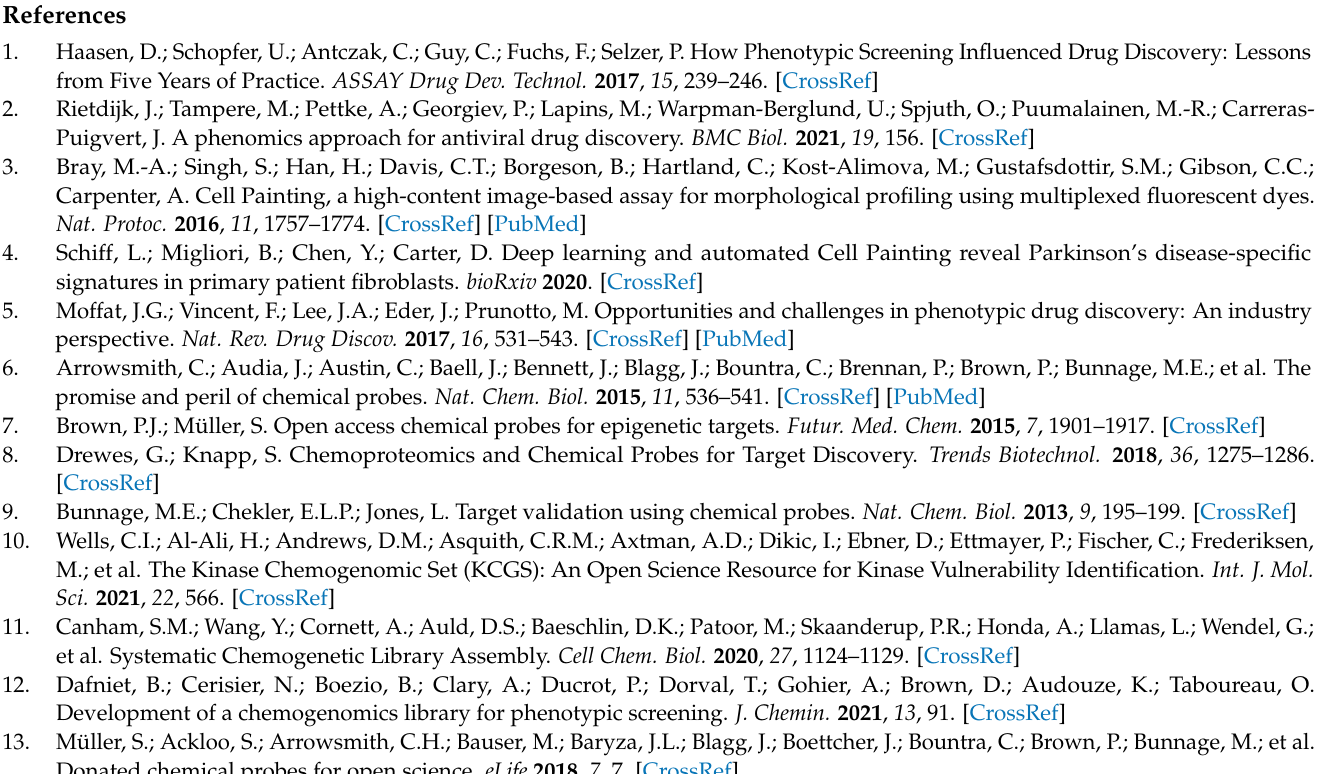
Table S4: Additional data FUCCI assay (Excel). Table S8: Multiplex Chemogenomic data